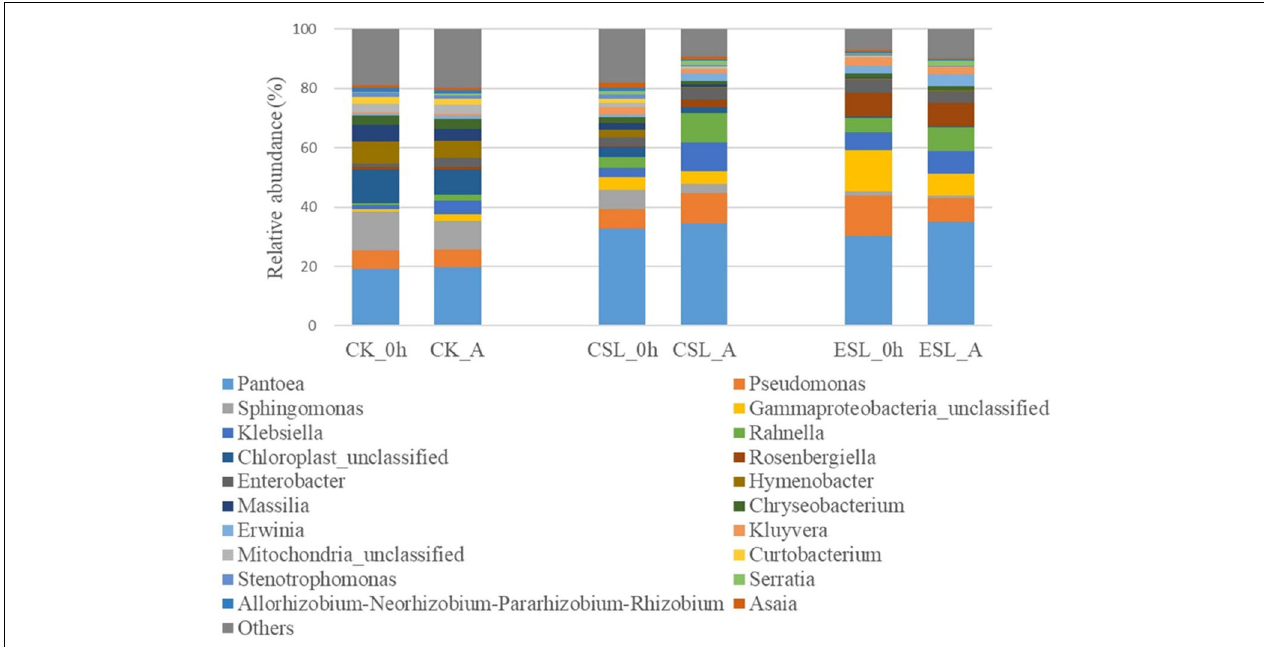
FIGURE 3 | Relative abundance of bacterial communities (genus level) in whole-plant corn silage before ensiling (0 h) and at anaerobic state (A). CK, whole-plant corn silage without any lactic acid bacterial suspensions; CSL, whole-plant corn silage treated with lactic acid bacterial suspensions prepared from whole-plant corn silage; ESL, whole-plant corn silage treated with lactic acid bacterial suspensions prepared from Elymus sibiricus silage.